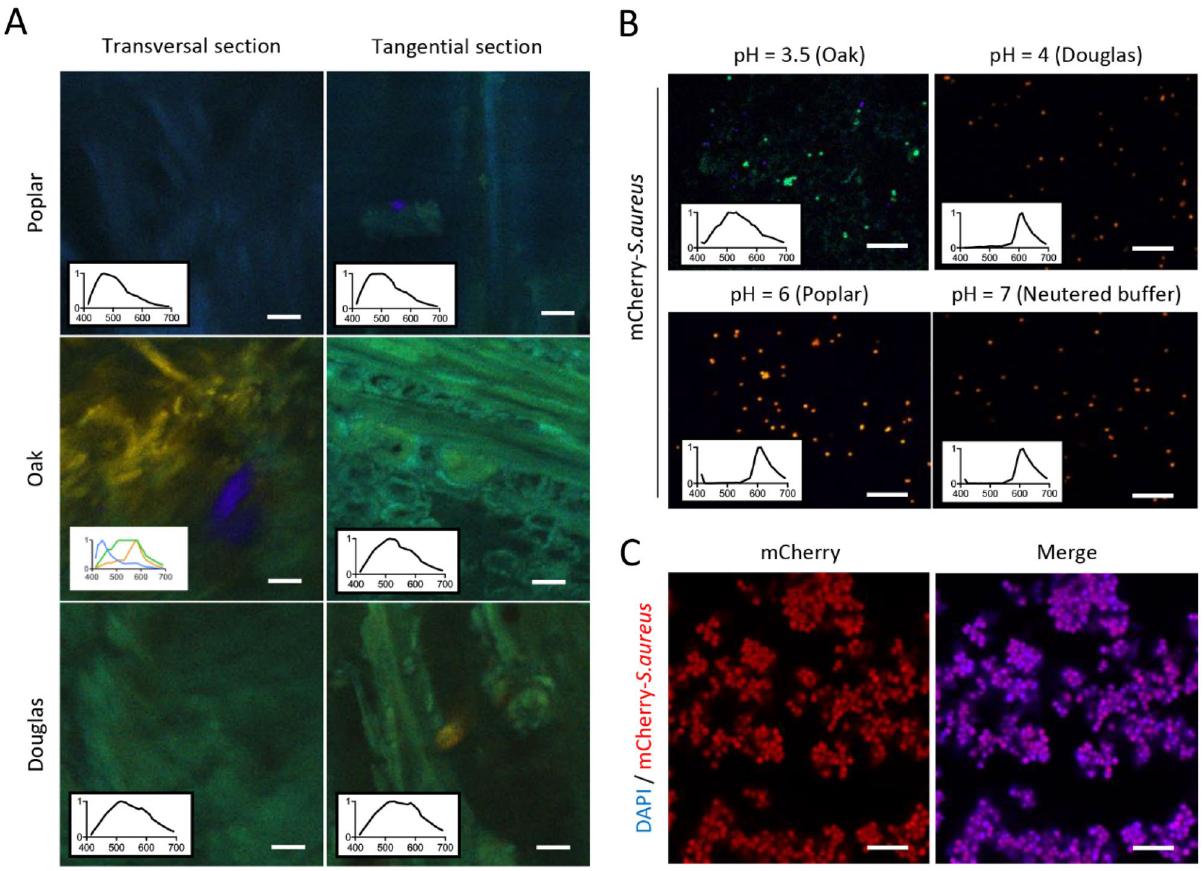
Figure 1. Wood imaging using spectral microscopy. (A) Spectral imaging of poplar, oak and Douglas fir autofluorescence (respectively, top, middle and bottom) with transversal (left) and tangential (right) section. Acquisition was performed with spectral confocal microscope (excitation at 405 nm, fluorescence spectra collection from 410 to 690 nm). The colors in the images in the Fig. 1A are pseudocolors which represented wavelengths emission. The mean spectra obtained from the images showed a large emission spectra between 400 nm (blue) and 700 nm (red) with more or less fluorescence in blue, green and yellow dependant of wood species and section orientation. 3 different spectra has ben assigned to oak RT section. Scale bar = 20 µm. (B) Spectral imaging of mCherry— Staphylococcus aureus at pH = 3.5 (oak pH), 4 (Douglas fir pH), 6 (poplar pH)